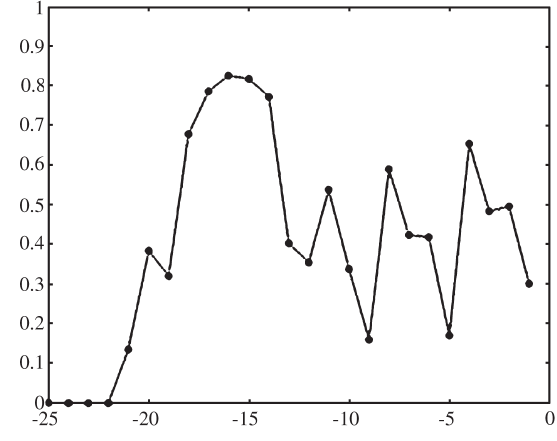
Figure 5 - All the answers to a single start codon, from one of the net-